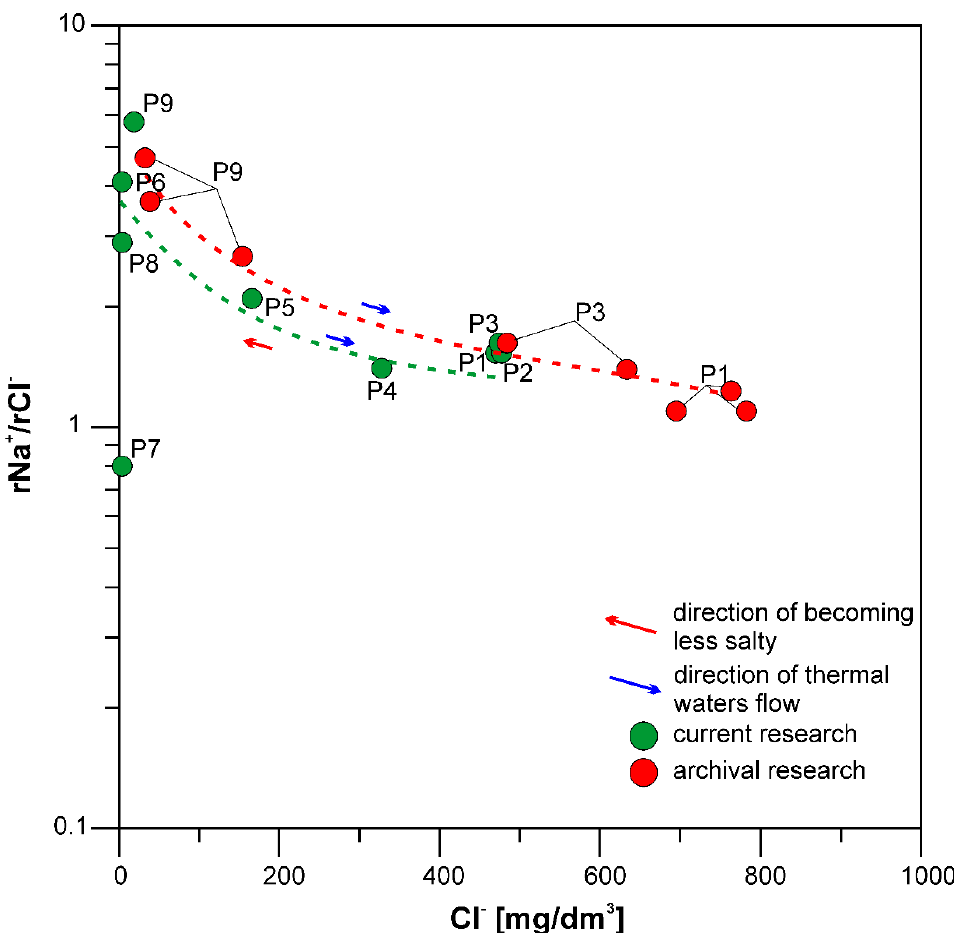
Figure 5. Change of the rNa + /rCl − index as the presumed effect of the process of reducing the thermal water salinity by meteoric water—comparison of current data and archival data [40].